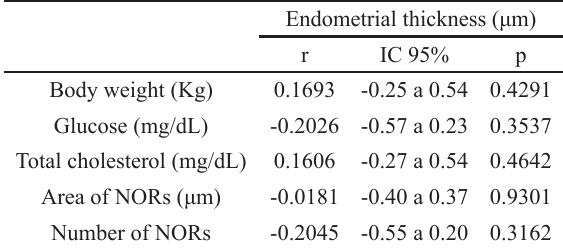
Pearson correlation coefficient (r) for association between endometrial thickness and body weight (n = 24), blood glucose (n = 23) and plasma cholesterol (n = 23) of bitches, average area of nucleolar organizer regions - NORs (n=24) and number of NORs (n=24), data estimated by point and interval with 95% confidence (CI95%) and statistical significance (p) of the t test, Presidente Prudente, 2014.